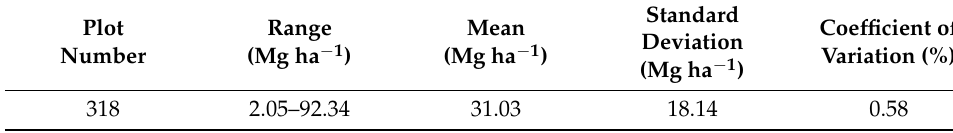
Table 1. Descriptive statistics of AGB field data from Durango temperate forests.